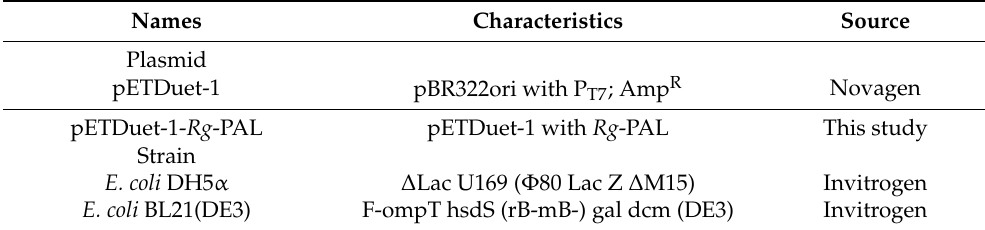
Table 1. Strains and plasmids used in this